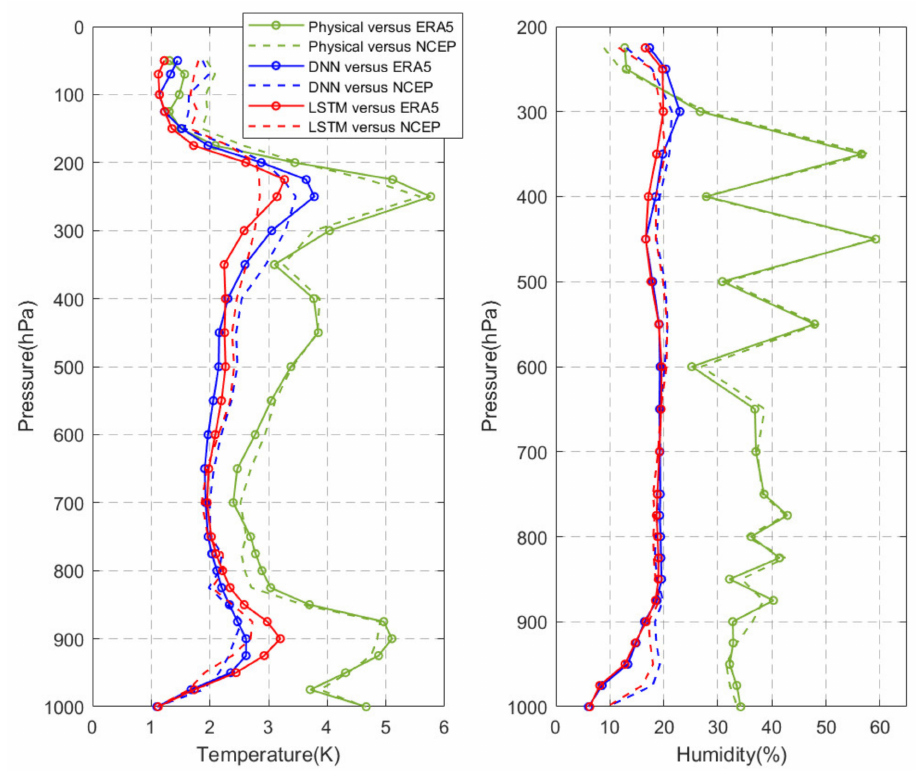
Figure 6. The retrieval RMSEs of the DNN model, the LSTM model, and the physical retrieval algorithm with respect to ERA5 and NCEP reanalysis data over sea ice in June